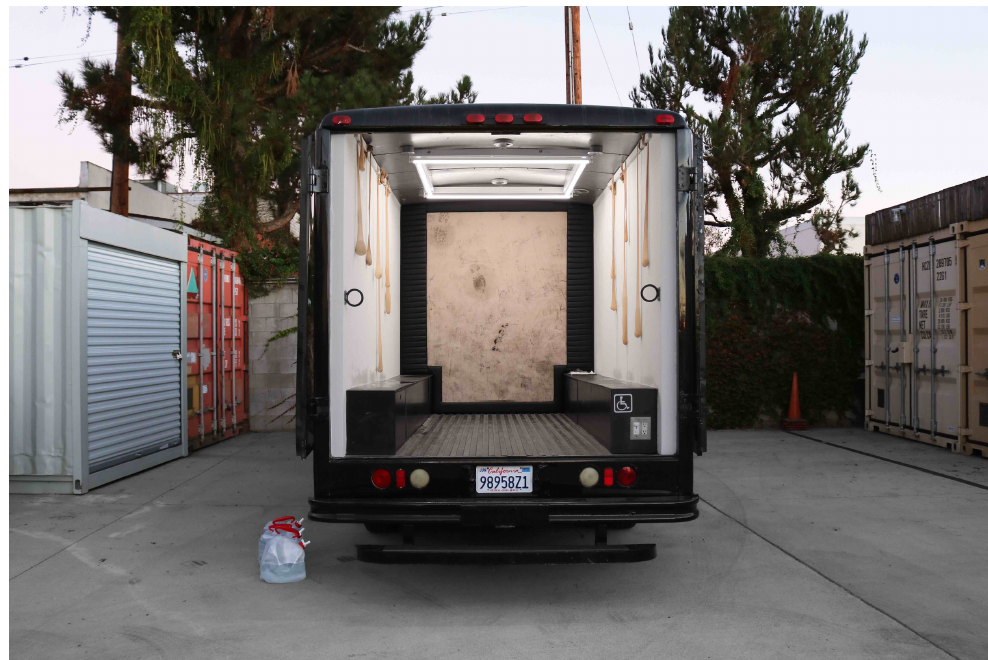
Figure 8: Anatomy of Oil exhibition, Gas Gallery, showing Oil rituals for the future #6 (2018). Photo: Andy Bennett and Colleen Hargaden. Reproduced with